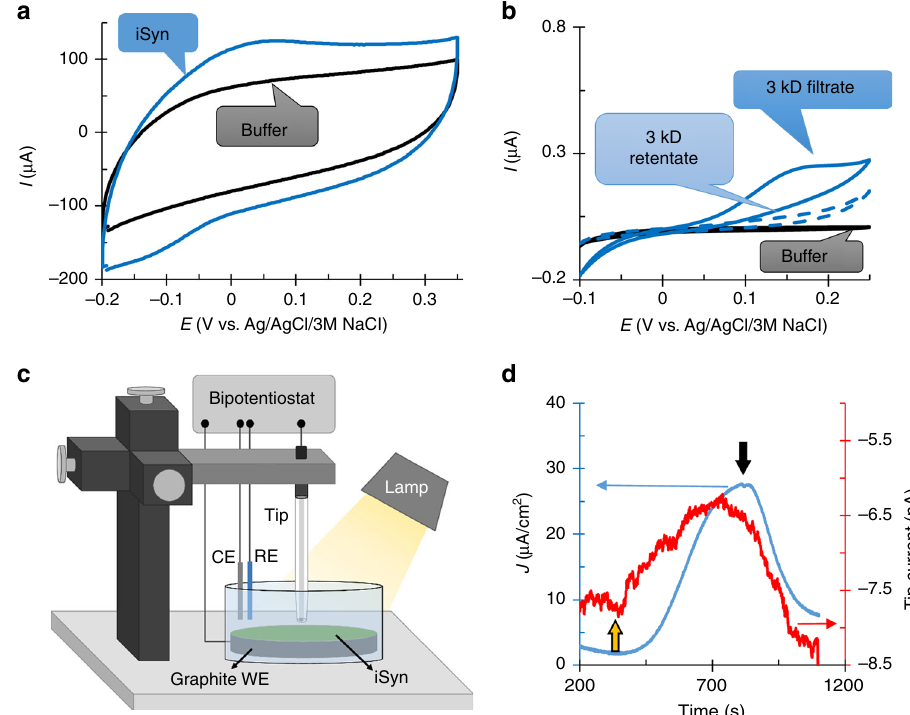
Fig. 5 iSyn electron transfer to the BPEC is via a diffusive endogenous mediator. a CV in the light for buffer (black) and the iSyn (blue) separated by a 3 kD dialysis membrane on the graphite electrode. b CV of supernatant fraction from centrifuged iSyn cells separated by fi ltration through 3 kD cut-off centricon. Filtrate (solid blue line), retentate (dashed blue), and buffer (black). c Illustration of the scanning electrochemical microscopy setup. iSyn settled on the working electrode (WE) electrode. The counter electrode (CE) is platinum, and the reference electrode (RE) a Ag/AgCl/3 M KCl. The tip is a carbon-based microelectrode with a mixture of bilirubin oxidase (BOD) embedded in an Os-complex modi fi ed polymer matrix. All electrodes are connected to the bipotentiostat. d CA of the iSyn (blue) and the BOD tip current (red) measuring the oxidation of the mediator at a distance of 30 µ m from the graphite